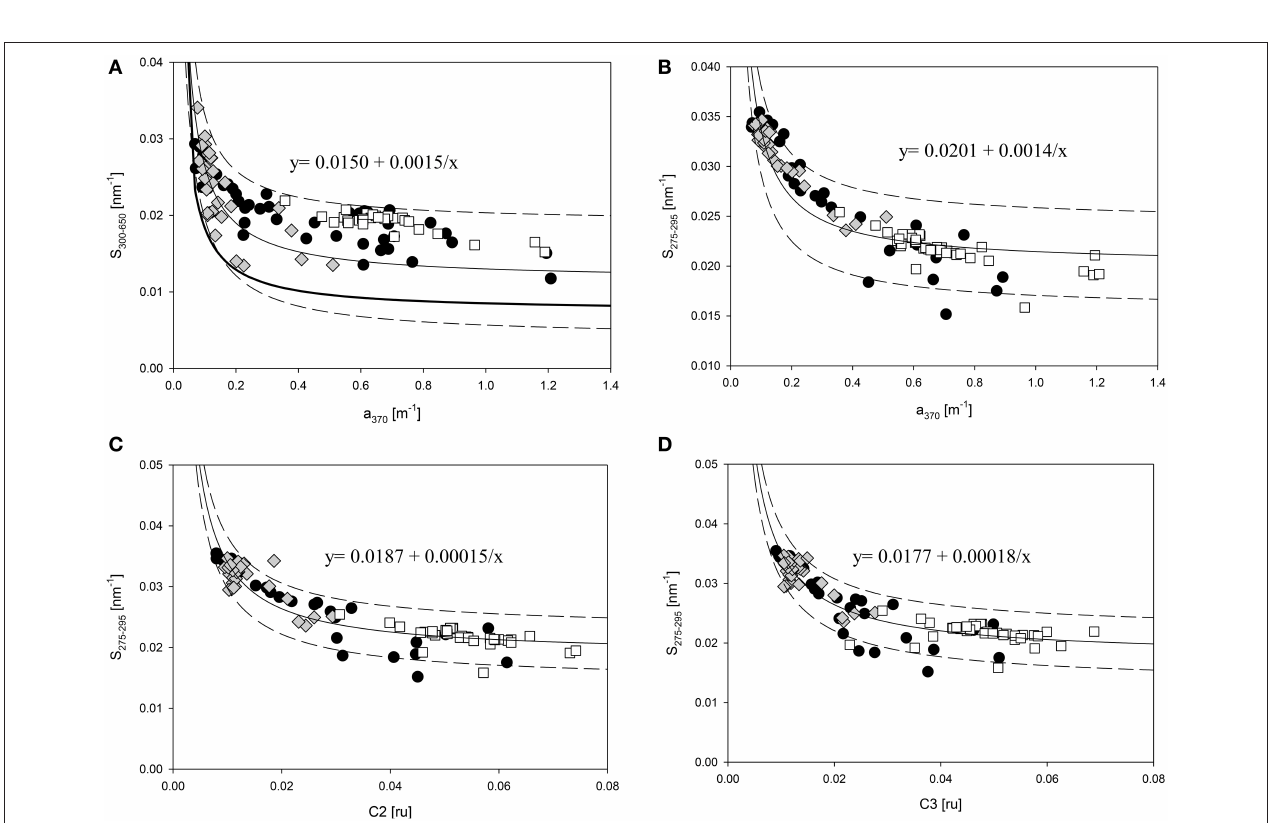
FIGURE 7 | CDOM spectral slopes (A) S 300 − 650 against a 370 , and S 275 − 295 against (B) a 370 , (C) C2 and (D) C3 in surface arctic waters ( 2 > 83 ◦ N region, (cid:7) 75-83 ◦ N region, and • < 75 ◦ N region). The bold and thin lines represent the model for Greenland and North Seas (Stedmon and Markager, 2001) and Arctic Ocean (This study), respectively. The dotted lines correspond to the 95% prediction band for the Arctic Ocean model.